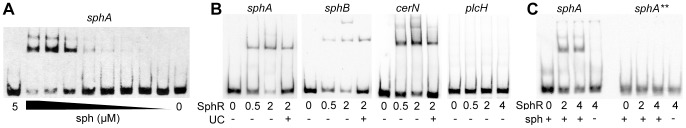
SphR directly binds to its target regulatory regions and binding is stimulated by sphingosine.The binding of MBP-SphR to target DNA was measured using electrophoretic mobility shift assays (EMSAs). (A) Sphingosine (sph) is required for robust MBP-SphR binding to target DNA and sphingosine stimulates SphR DNA binding in a dose-dependent manner. Based on this data all subsequent EMSAs were conducted with 10 µM sphingosine. (B) MBP-SphR (SphR) binds in a dose-dependent manner to sphA, sphB, and cerN upstream regulatory regions, but not to the sphR-independent plcH regulatory region. The MBP-SphR concentration (µM) is shown below the lanes. Specificity is shown by lack of MBP-SphR binding to the plcH promoter and by the ability to compete the bulk of the shift with unlabelled competitor DNA (UC) denoted by the + sign under the lanes. (C) MBP-SphR binds a 59-bp oligonucleotide probe containing the predicted SphR binding site upstream of sphA. The extra shifts seen in panels A & B are absent from the EMSAs with these minimal probes and likely are due to additional interaction sites. Mutation of two conserved residues in half-site #1 (TG to AA) (sphA**) results in substantial reduction in MBP-SphR binding. All experiments were performed at least three times and data shown is representative of all experiments.